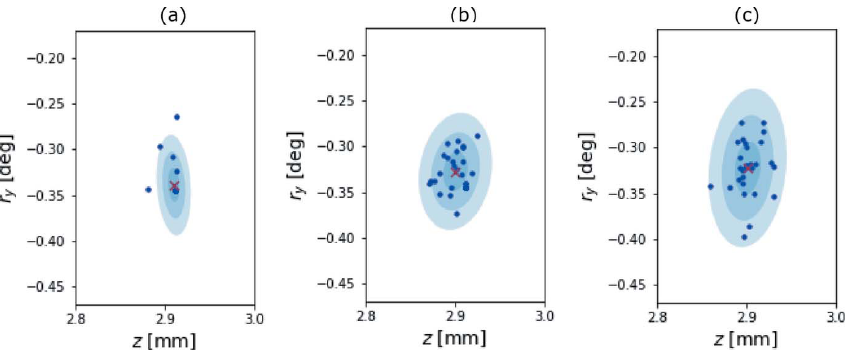
Figure 7 Depicted are the spatial results of three Monte Carlo simulations, in two of the four total dimensions. We varied the additive noise parameter & between each sampling. Panel ( a ) depicts the case where & = 5.0 (cid:5) 10 (cid:3) 4 , ( b ) shows the case where & = 5.0 (cid:5) 10 (cid:3) 3 , and ( c ) shows the & =